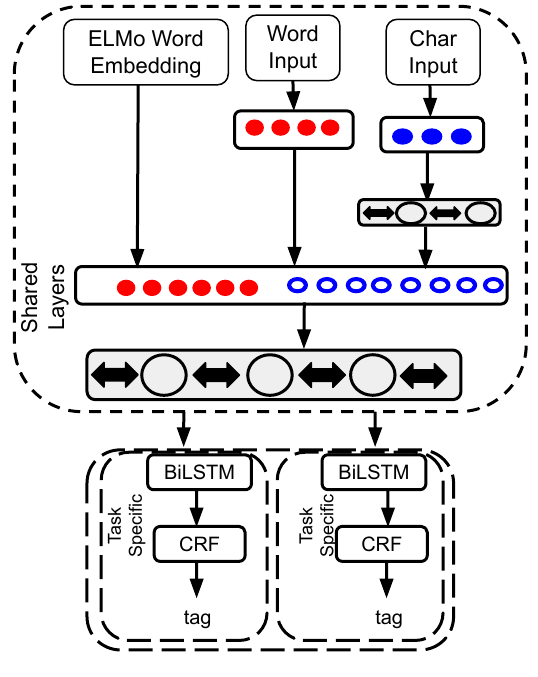
Figure 6. Integration of ELMo in the